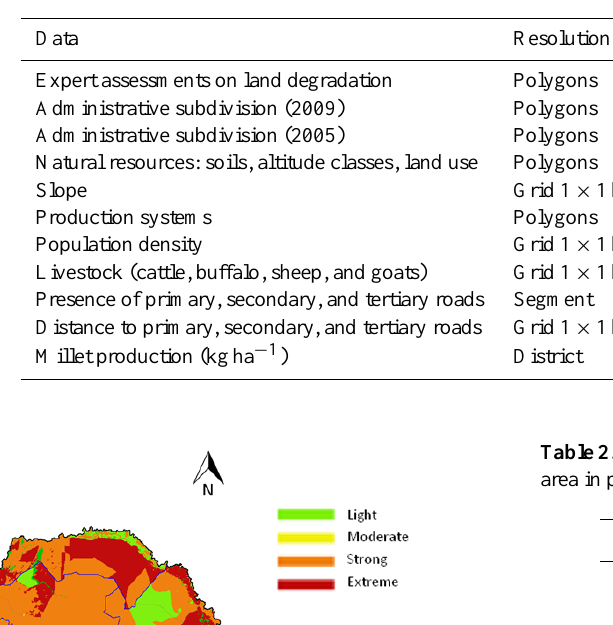
Table 1. Data, geographical resolution, and source.